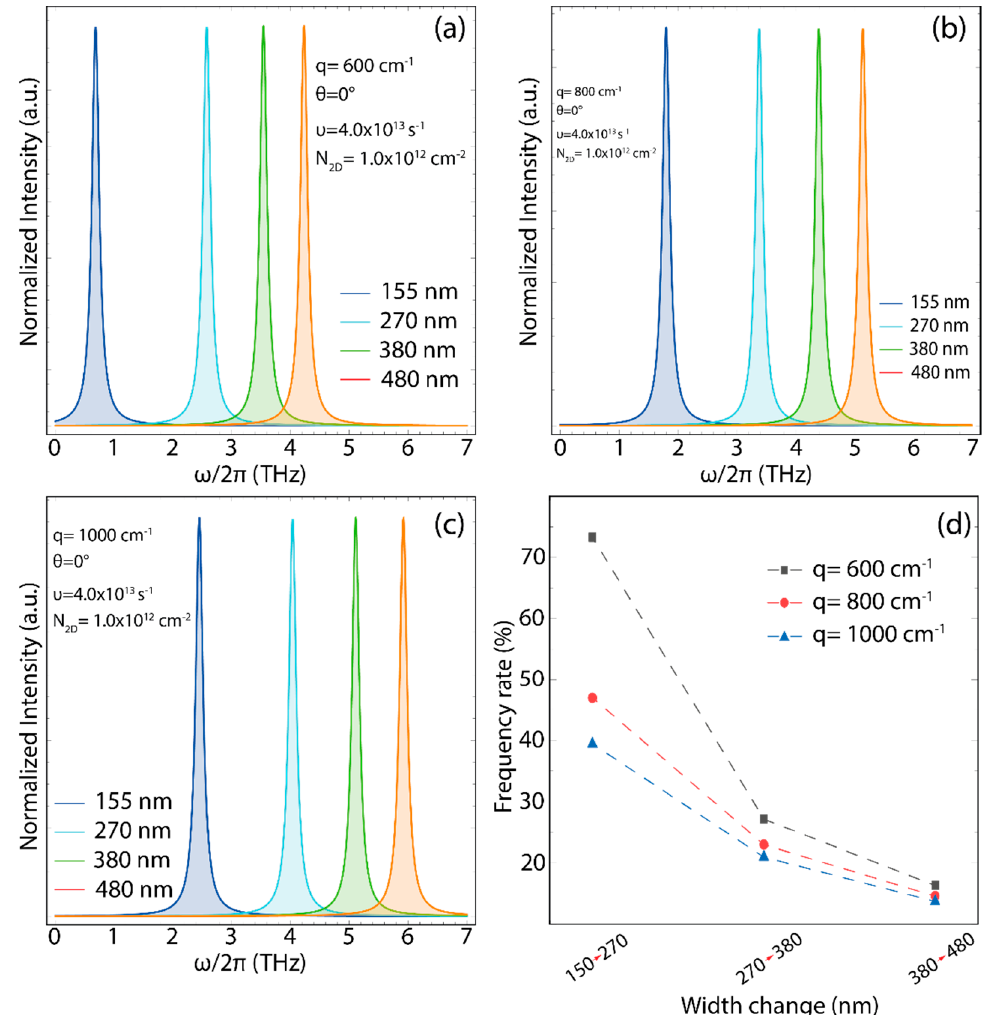
Figure 12. Plasmon excitation lifetime ( ≤ 7 THz) at ( a ) q = 600 cm − 1 , ( b ) q = 800 cm − 1 , and ( c ) q = 1000 cm − 1 considering different ribbons widths (155, 270, 380, and 480 nm). ( d ) Percentage variation in plasmon frequency by increasing ribbon width for three different q values ( q = 600, 800, 1000 cm − 1 ). The parameters of Equation (4) have been fixed as: N 2 D = 1.0 × 10 12 cm − 2 , θ = 0, ν = 4.0 × 10 13 s − 1 , and v F = 0.829 × 10 6 m s − 1 . The plasmon spectra were calculated using the Lorentzian shape function to a maximum value of 1 with FWHM =